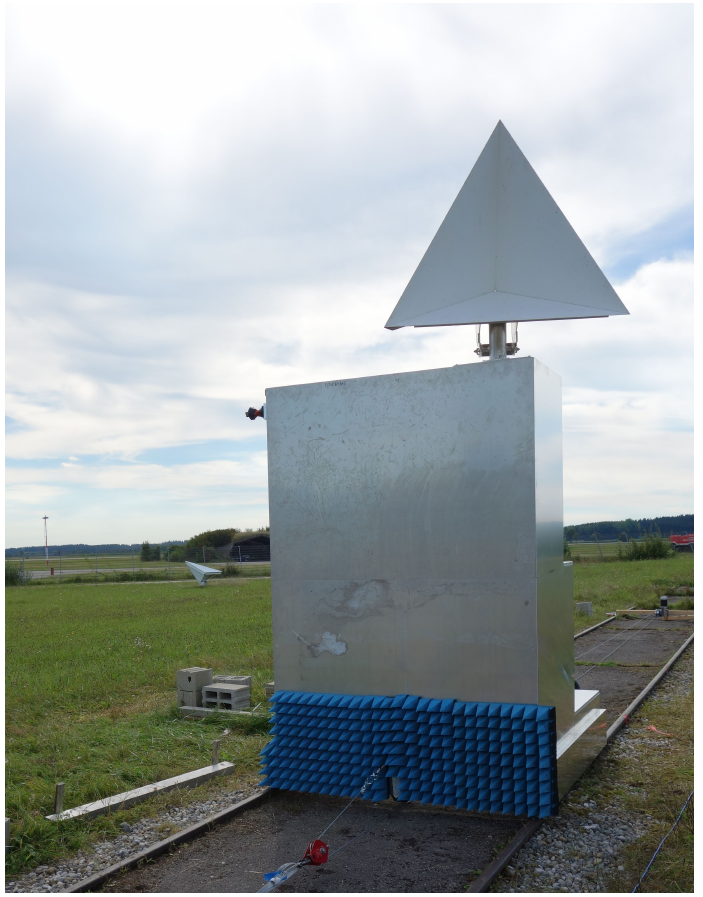
Figure 4. Measurement setup of the railway cart including absorbing material to reduce its